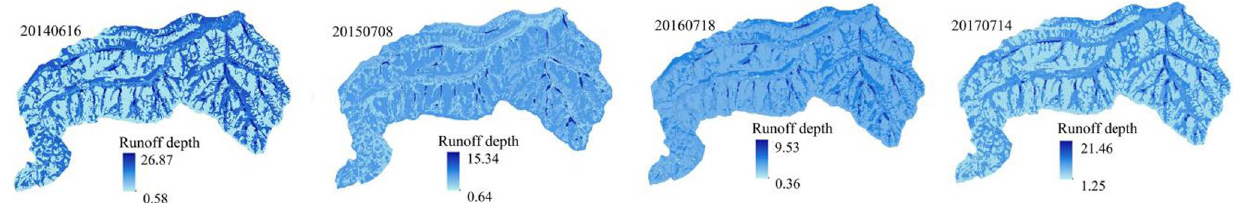
Fig. 11 Example: Runoff depth distribution in 4